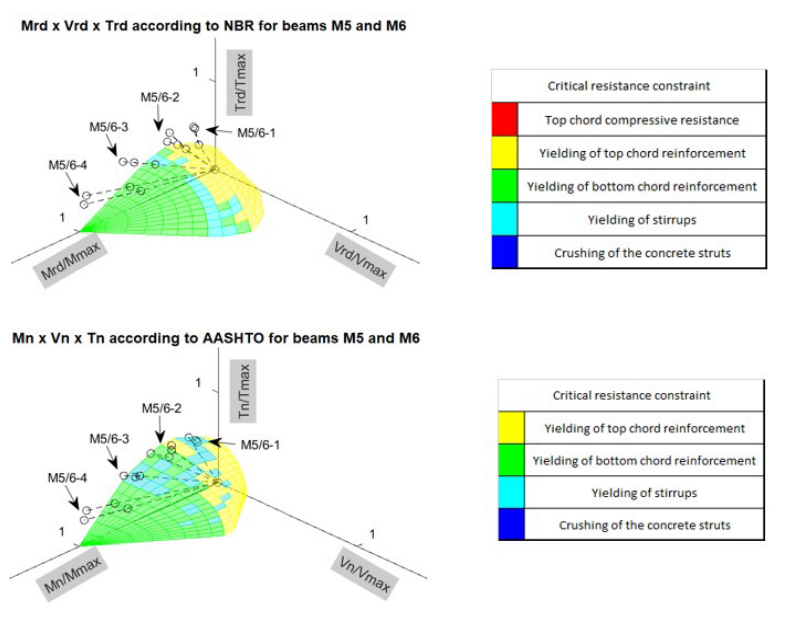
Figure 22: Interaction surface according to NBR and AASHTO for beams M5 e M6.